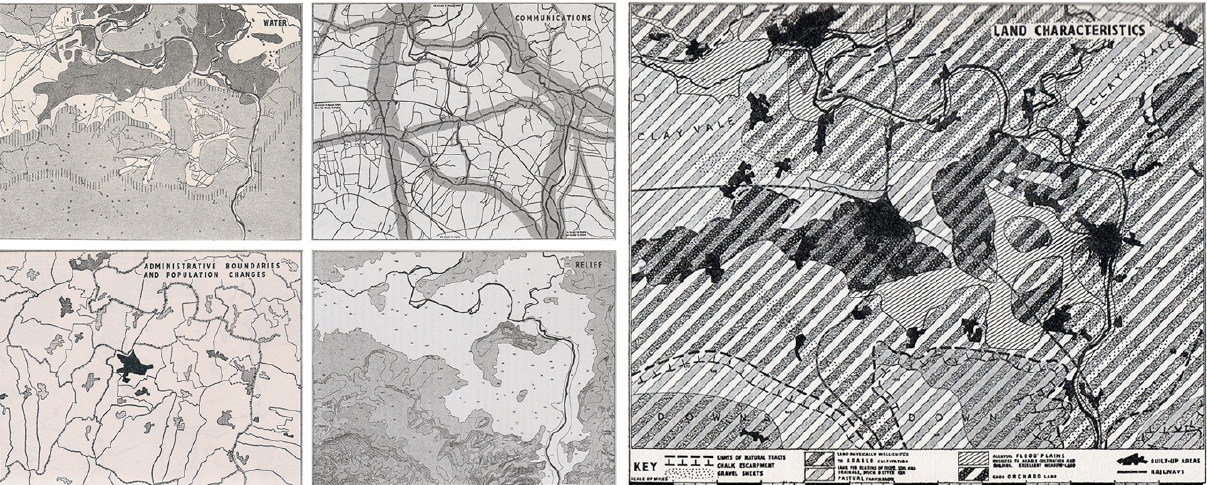
Figure 3. Example used by Tyrwhitt to explain the overlaying technique as a tool for research. Thematic maps on water, communications (infrastructure), administrative boundaries, population changes, etc., resulting in a synthesis map point- ing out the characteristics of the landscape. Source: Tyrwhitt